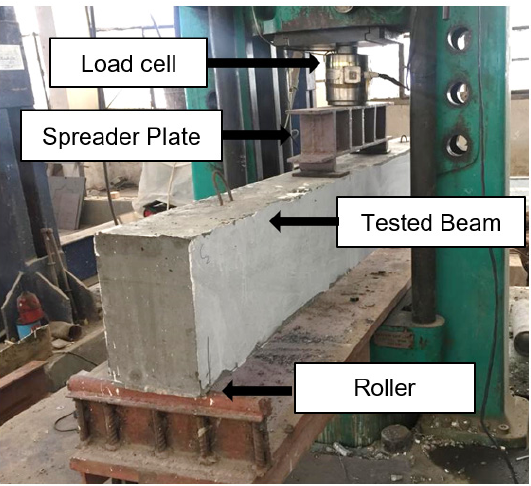
Figure 2. Sample Strengthening, Instrumentation and Loading.